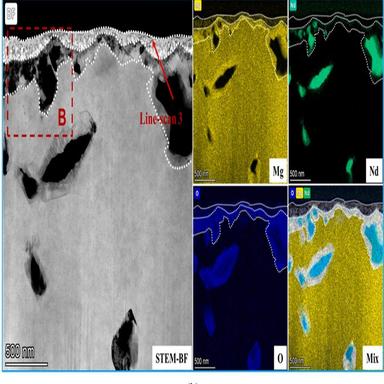
(a) STEM-BF image and corresponding EDS elemental distribution maps of the region occupied by Mg12Nd precipitate after oxidation for 100 h; (b) STEM-BF image and corresponding EDS elemental distribution maps of the region free of Mg12Nd precipitate after oxidation for 100 h; (c) EDS line-scan 3 showing the elemental distribution across the duplex surface oxide scale and the underneath internal oxide precipitate in (b); (d) enlarged STEM-BF image and corresponding EDS elemental distribution maps of Region B